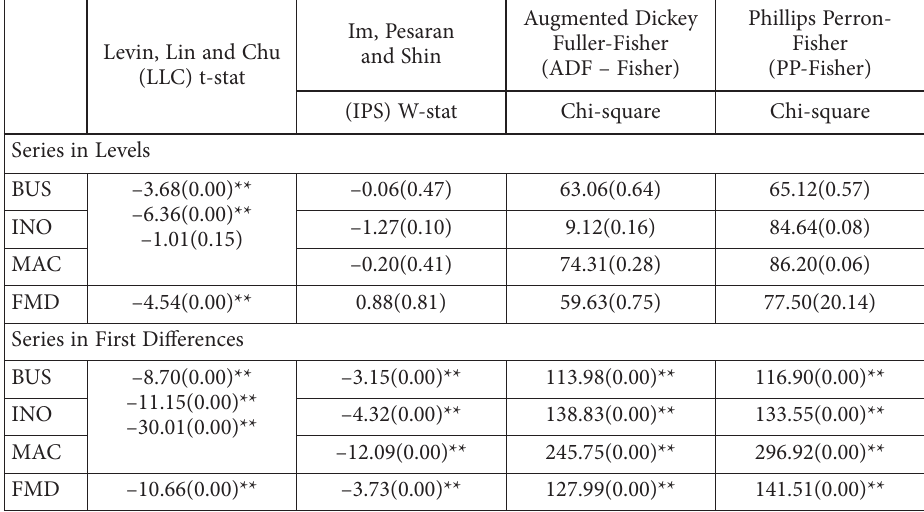
Augmented Dickey Im, Pesaran Fuller-Fisher and Shin (ADF – Fisher) (IPS) W-stat Chi-square Chi-square